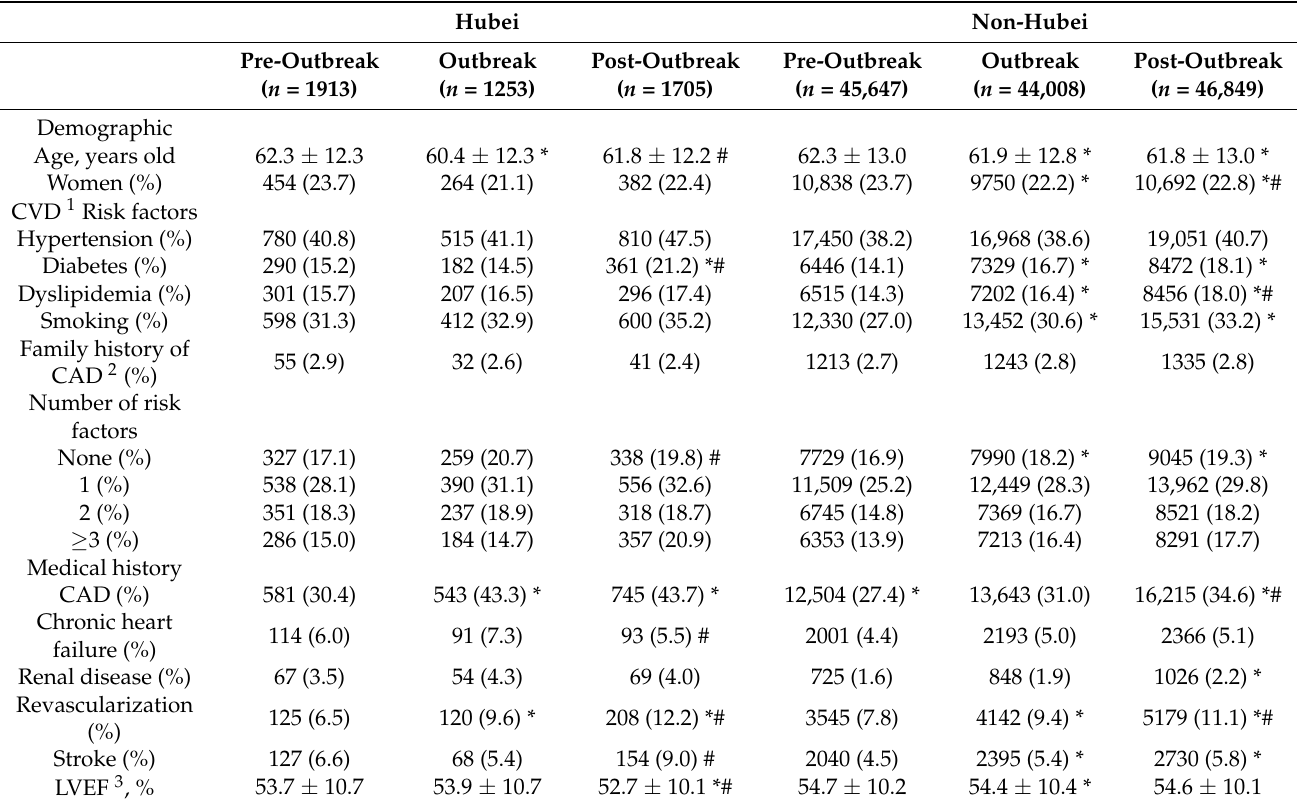
Table 1. Baseline characteristics. Hubei